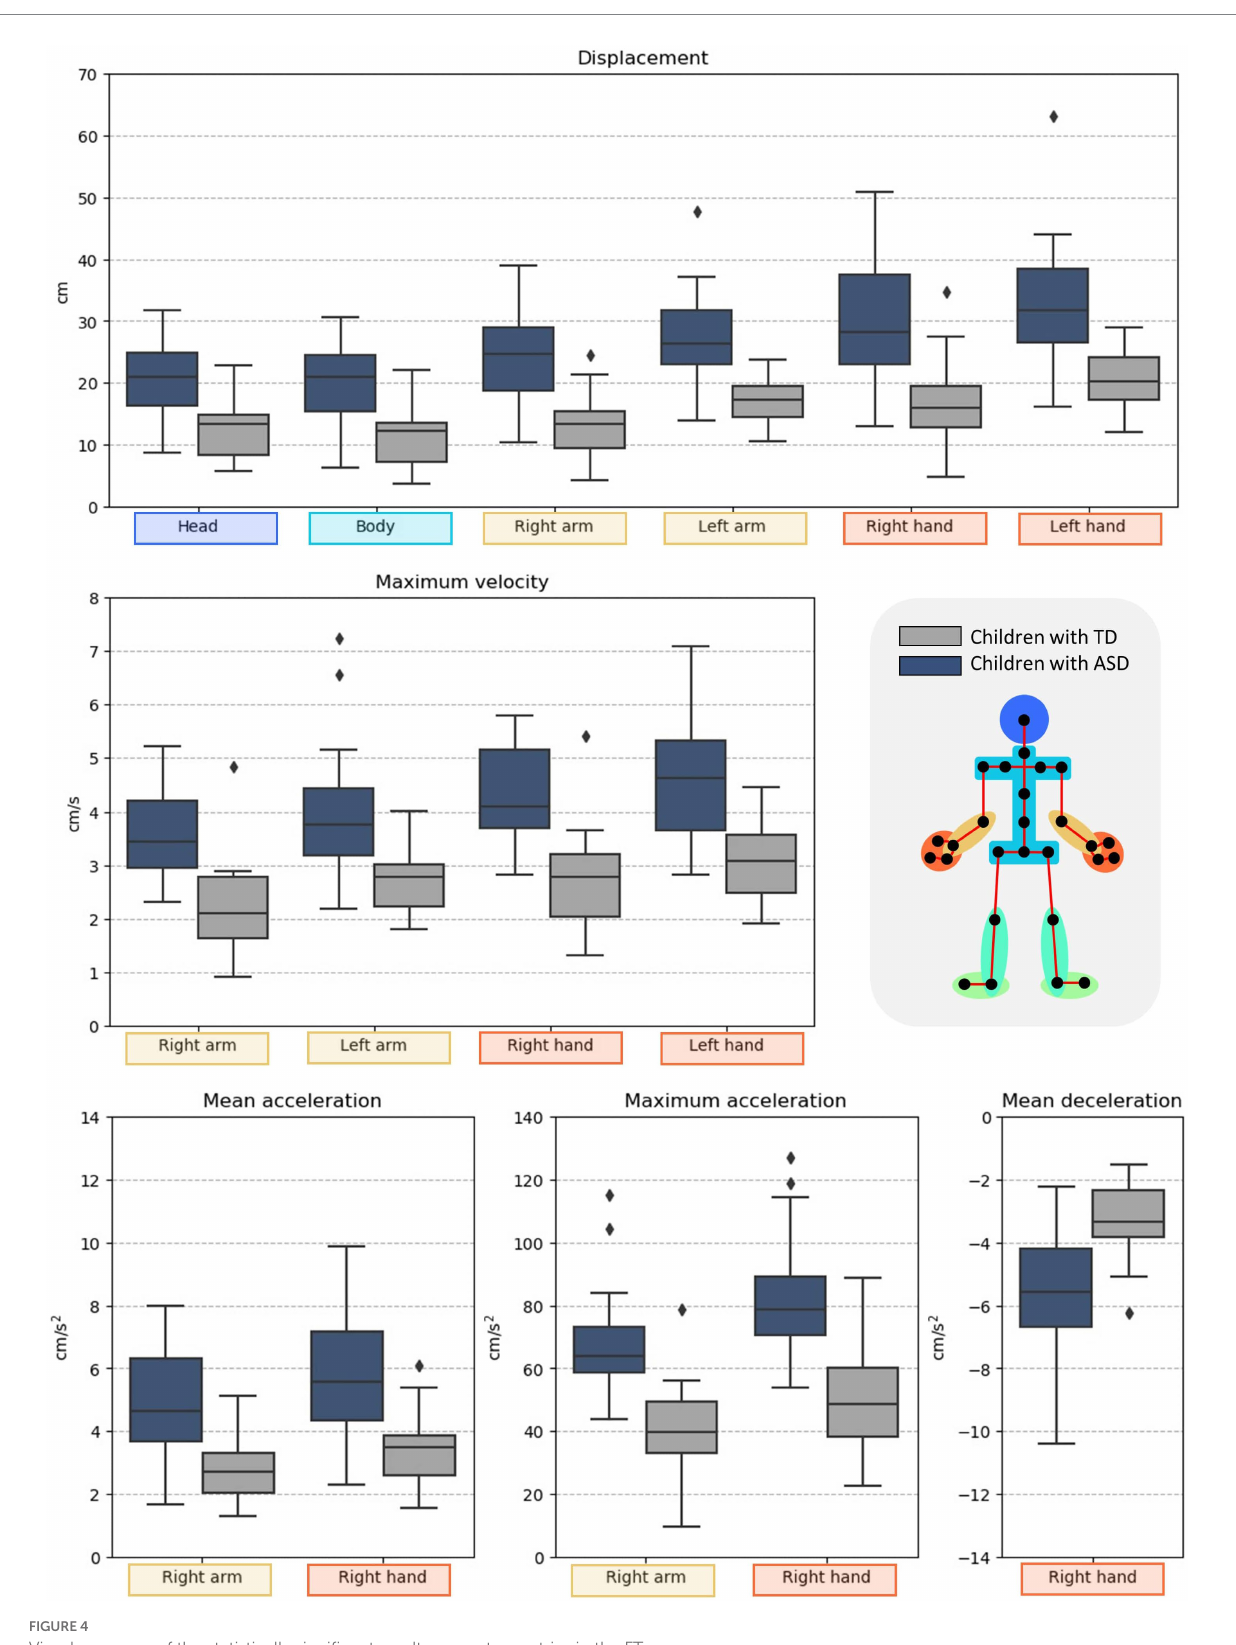
FIGURE 4 Visual summary of the statistically significant results on motor metrics in the